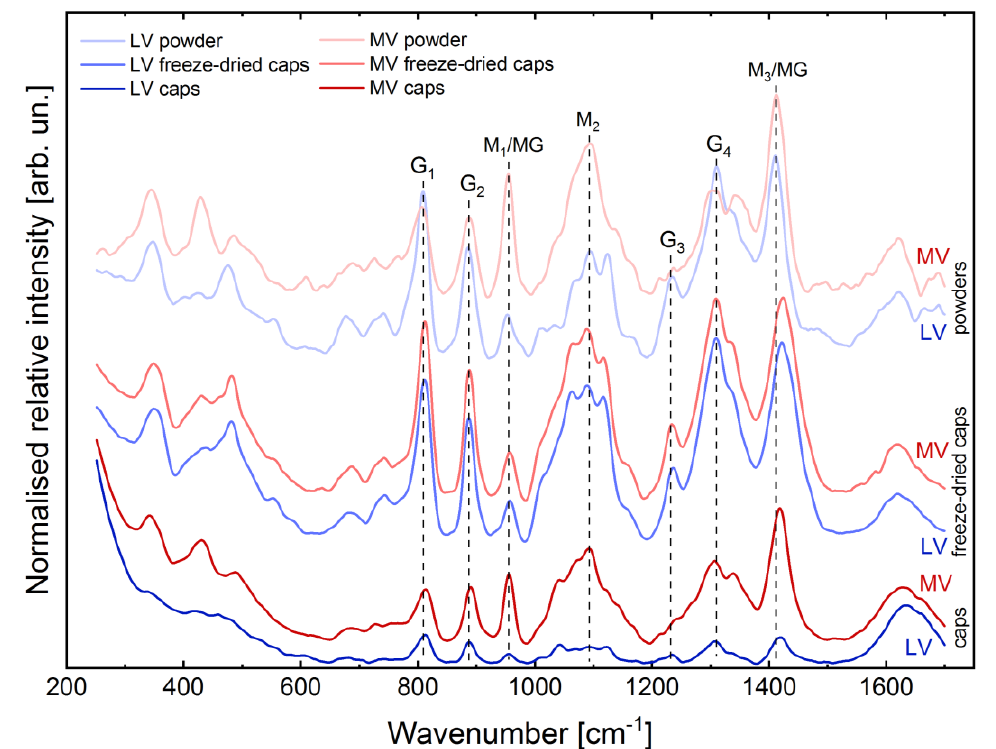
Figure 2. RAMAN spectroscopy of initial materials (powders) as well as produced core-shell capsules before (caps) and after freeze-drying (freeze-dried caps). M 1 –M 3 and MG are the main bands associated with M- and MG-blocks, respectively; G 1 –G 4 are the main bands associated with G-blocks; LV and MV are low (high-G) and medium (high-M) viscosity alginates,